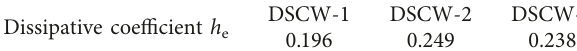
Table 4: Equivalent viscous damping